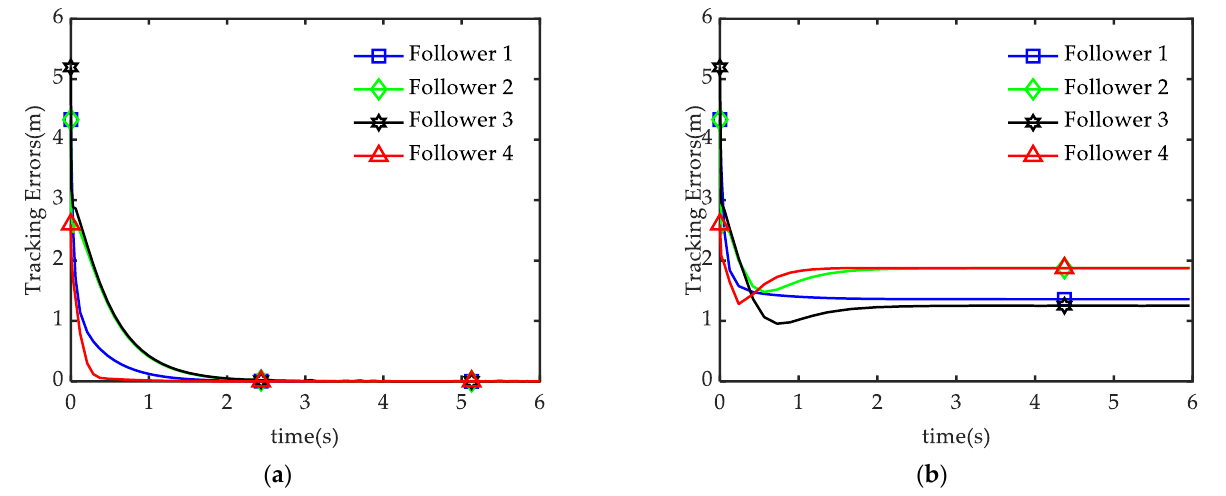
Figure 8. Variation curves of the time-varying formation tracking errors of four followers. ( a ) Current approach; ( b ) Previous Approach [24].